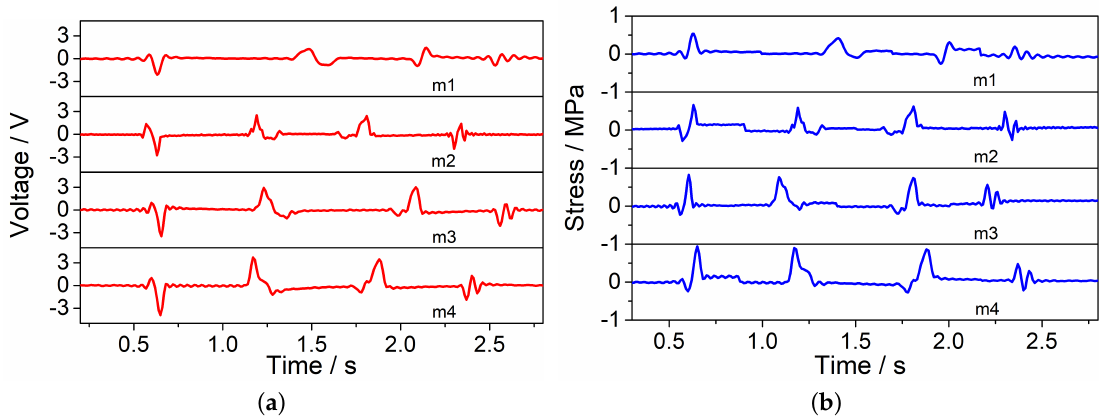
Figure 7. The results of moving loads experiments. ( a ) Voltage signals of PZT bimorph under four different loads (26.5 kg, 46.5 kg, 66.5 kg, 86.5 kg); ( b ) Identified results of PZT bimorph under four